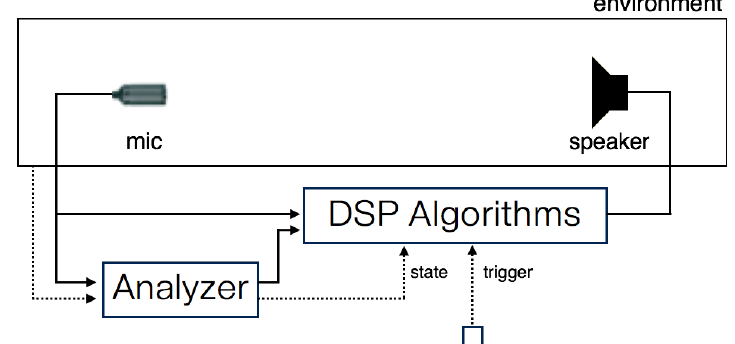
Figure 2. Structure of feedback-based audio/music systems (redesigned diagram of Figure 2 in [2]). The analyzer extracts the environmental information from the audio signal and controls the state